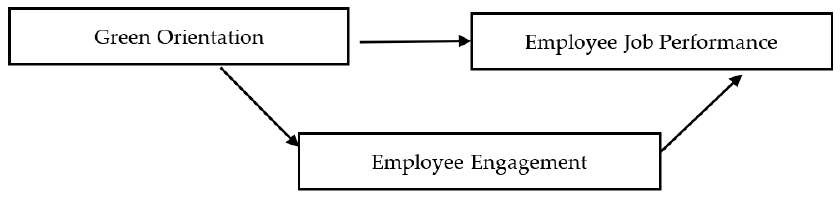
Figure 1. Nomological Network.